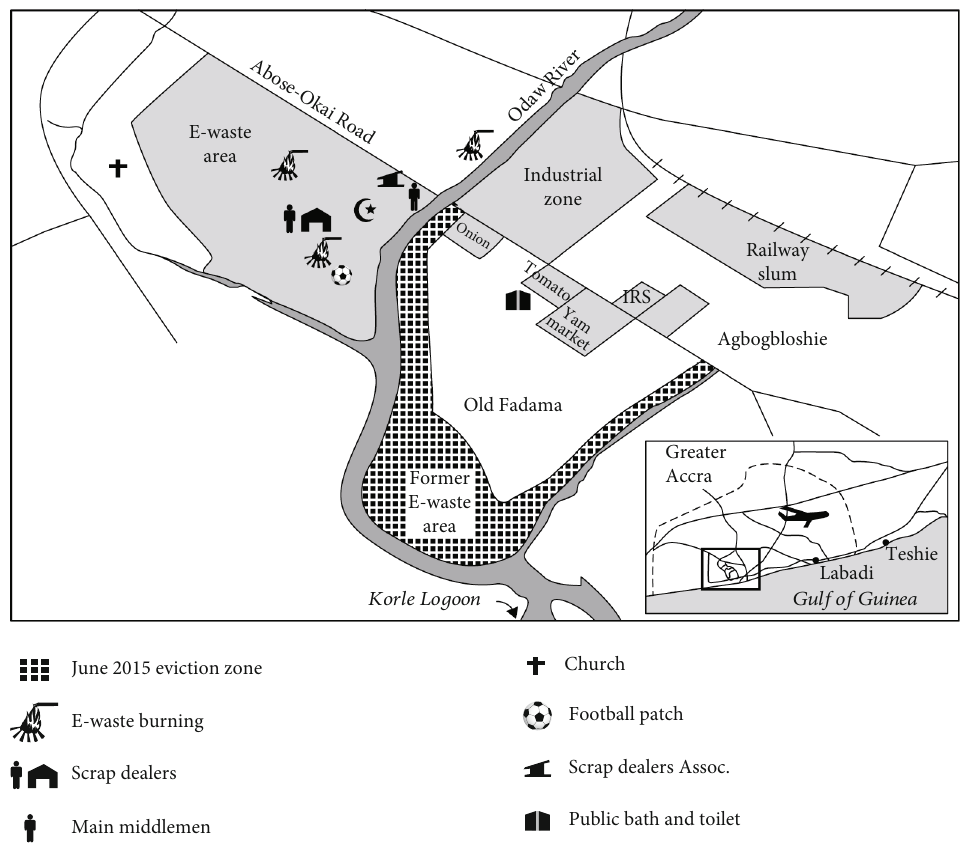
Figure 1: Catchment area of Agbogbloshie in the Greater Accra Region. Source: Adopted from Daum et al.